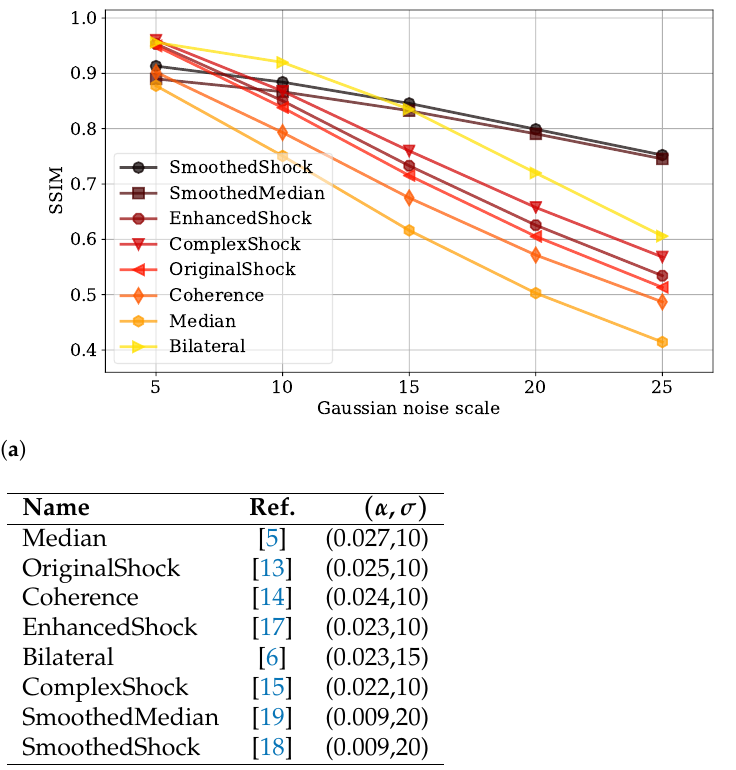
Figure 5. Evaluation of ( α , σ ) -robustness for several image denoising algorithms, compared to smoothed shock filtering, by studying quality function decrease through scales of noise ( a ) or numerically by appreciating the ( α , σ ) values for each algorithm ( b